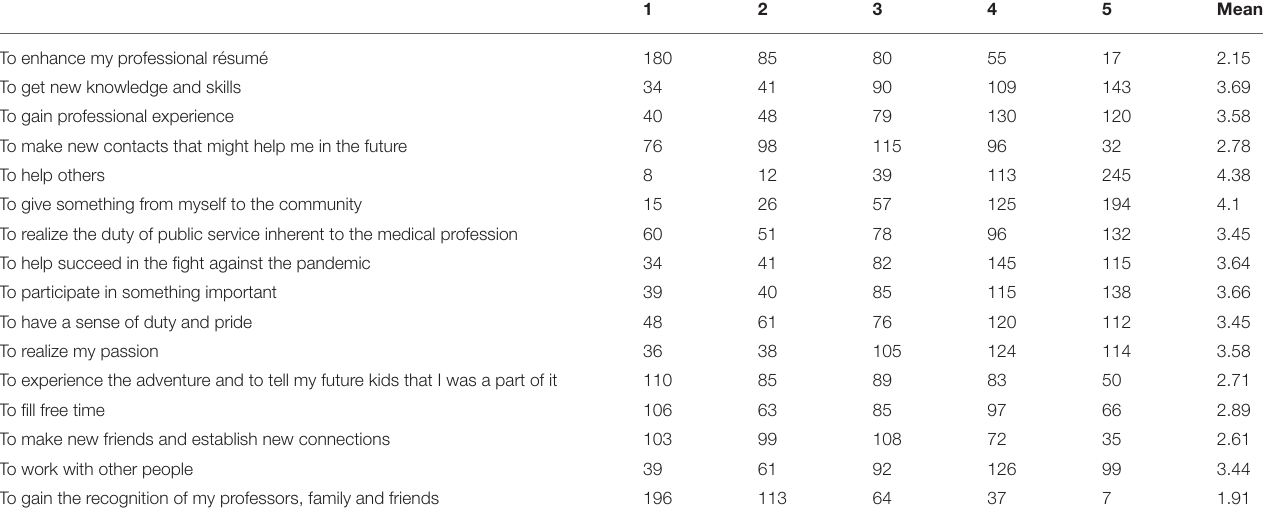
TABLE 5 | Students’